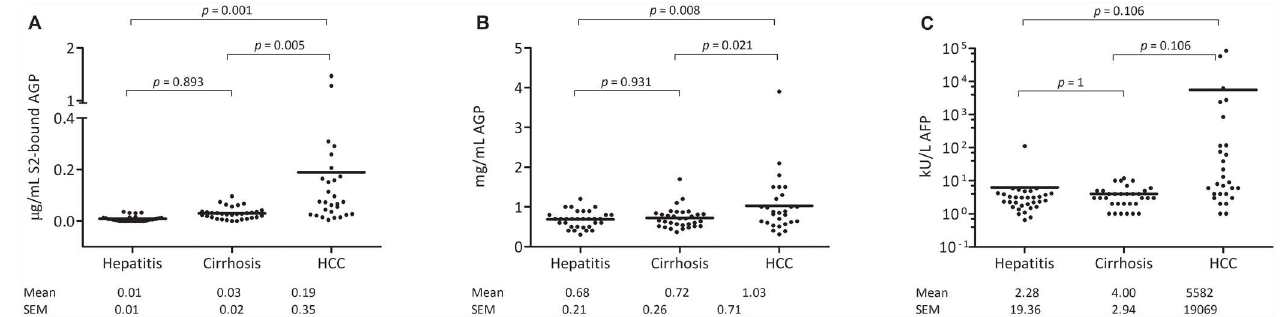
Fig 4. Scatter plots of levels of S2-bound AGP (as μ g/ml of dsAGP standard) (A), AGP (B), and AFP (C) in patients with hepatitis, cirrhosis and HCC.